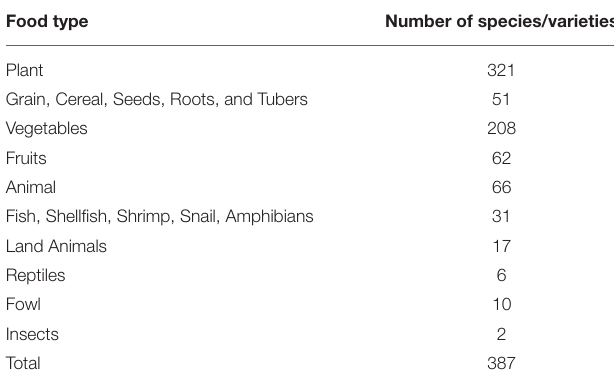
TABLE 4 | Summary of Karen traditional food